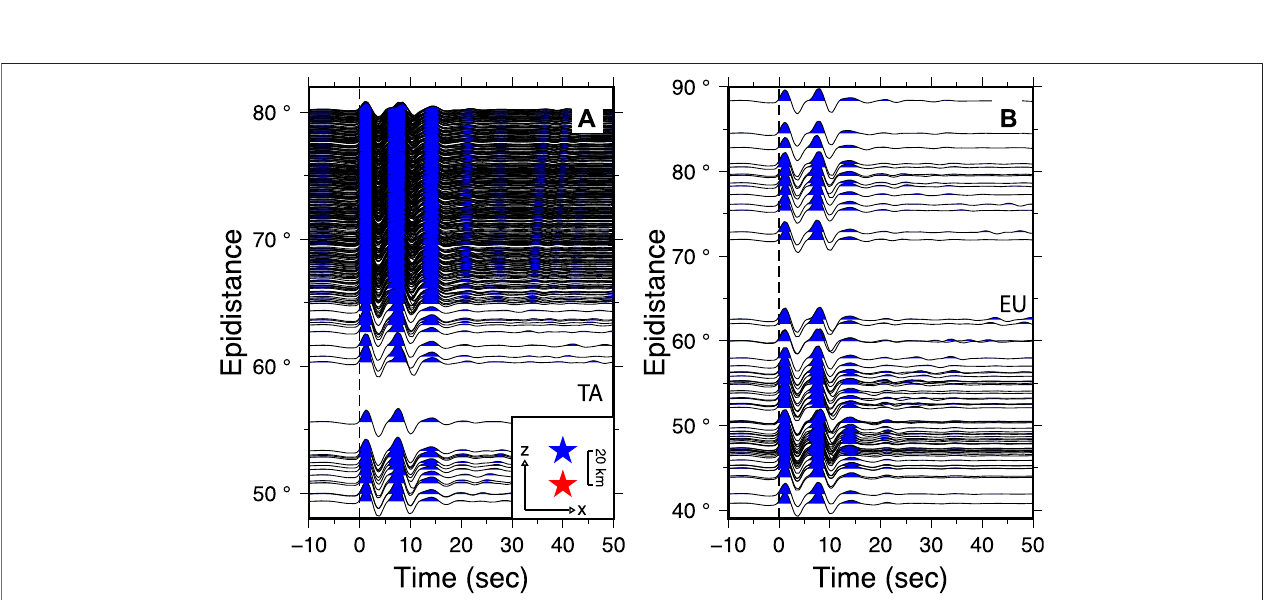
FIGURE 6 | Synthetic waveforms for (A) TA and (B) EU arrays in a frequency band of 0.1 – 0.5 Hz. Inset of (A) . The fi rst seismic source (red star) initiates at 0 s and the second one (blue star) bursts at 5 s and 20 km above the fi rst one.